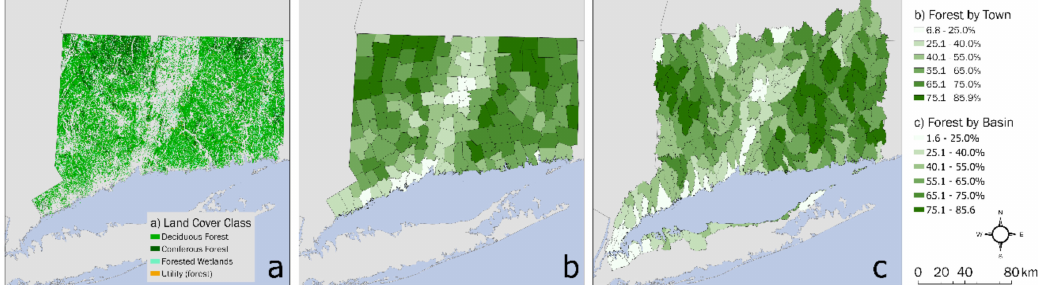
Figure 6. Examples of maps showing ( a ) statewide forest cover, ( b ) forest area by town, and ( c ) forest area by HUC-12 watershed where darker greens are more forested areas than lighter